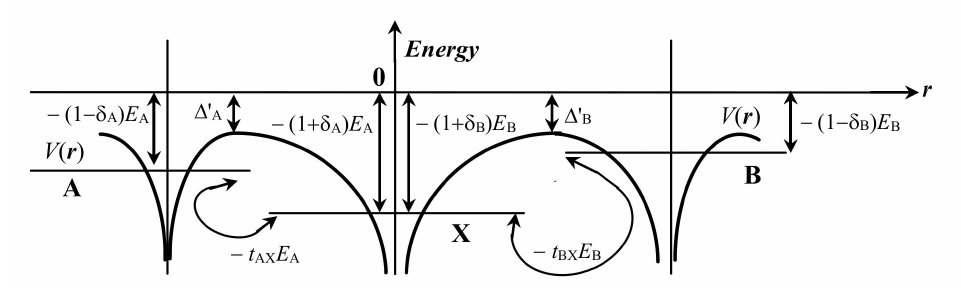
Figure 3. Radial behavior of energy for the centrosymmetric entity AXB in the general case of different magnetic sites (A (cid:54) = B) on both sides of ligand